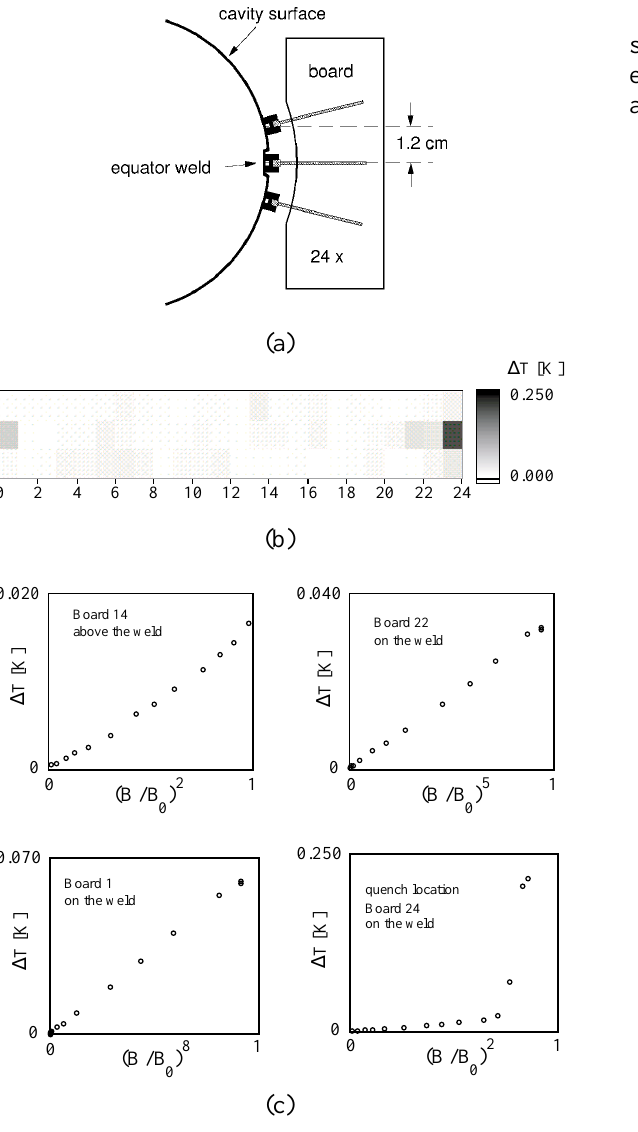
FIG. 18. (a) Location of temperature sensors to determine heating at the equator weld. (b) Temperature map of the equator region from cell 5 of cavity C9 just below the quench.